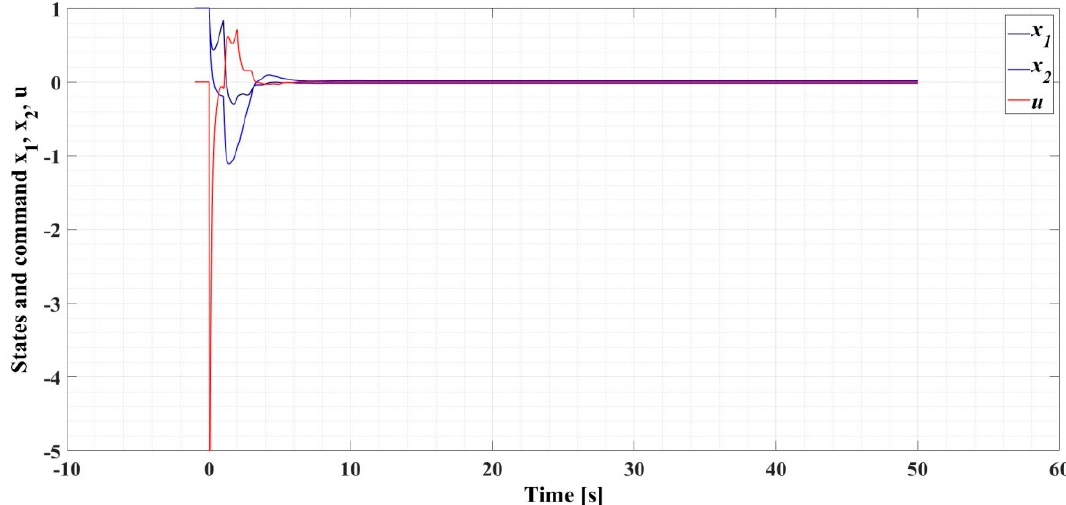
Figure 4. Evolution of the states without input saturation.